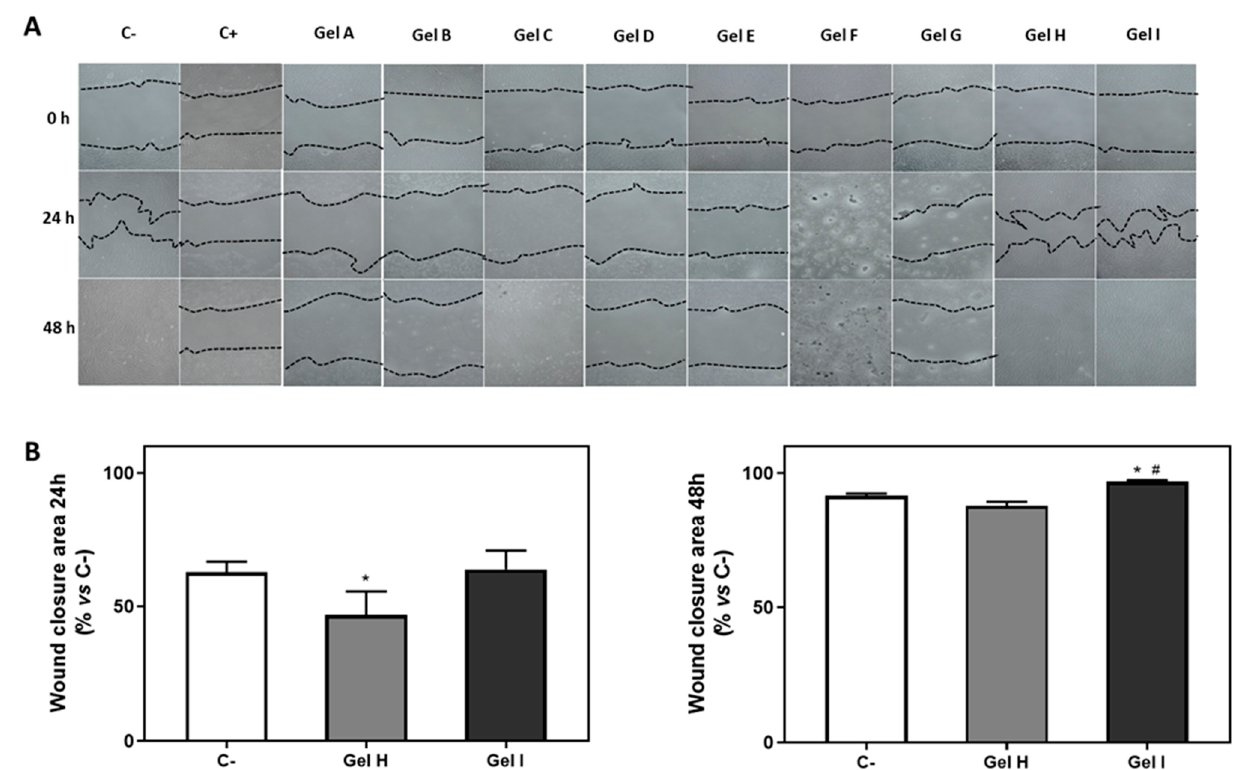
Figure 5. Wound healing assay after periodontal gel treatment. ( A ) Images of wound healing 24 and 48 h after treatment with the different gels, images were taken at a magnification of 100 × . ( B ) images of % of wound closure area after 24 h and 48 h of healing in the presence of Gel H or Gel I, in relation to Control. Negative control (C − ) was obtained from cells seeded on plastic without treatment and Positive control (C+) was obtained from cells seeded on plastic treated with CHX at 0.2%. See Table 1 for the identification of gels used in the study. Results are expressed as % vs. Negative control that was set to 100%. Values represent the mean ± SEM ( n = 6). Results were statistically compared by ANOVA and LSD as post hoc: * p < 0.05 treatment vs. negative control. # p < 0.05 treatment vs. Gel H.